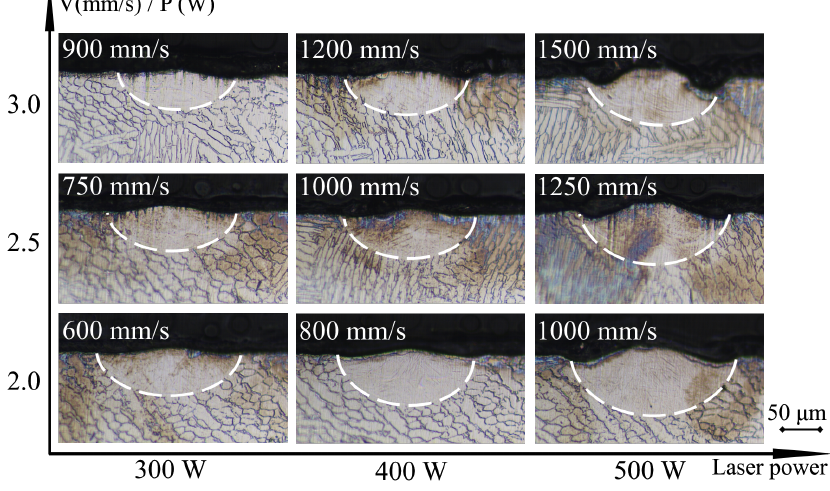
Figure 5. Cross section of each track, with melt pool boundaries highlighted by white dashed curves. Scale = 50 µ